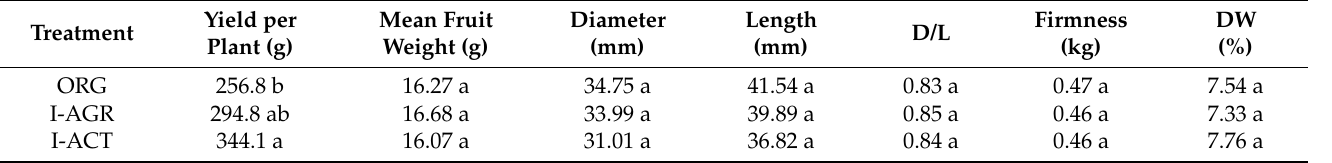
Table 1. Effects of cultivation management on yield per plant and fruit physiological characteristics during the experimental period.